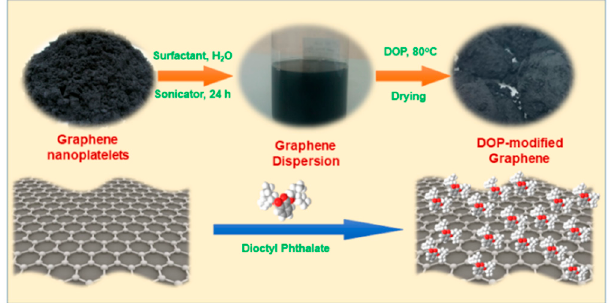
Figure 1. Fabricating process of the dioctyl phthalate-modified graphene nanoplatelets.